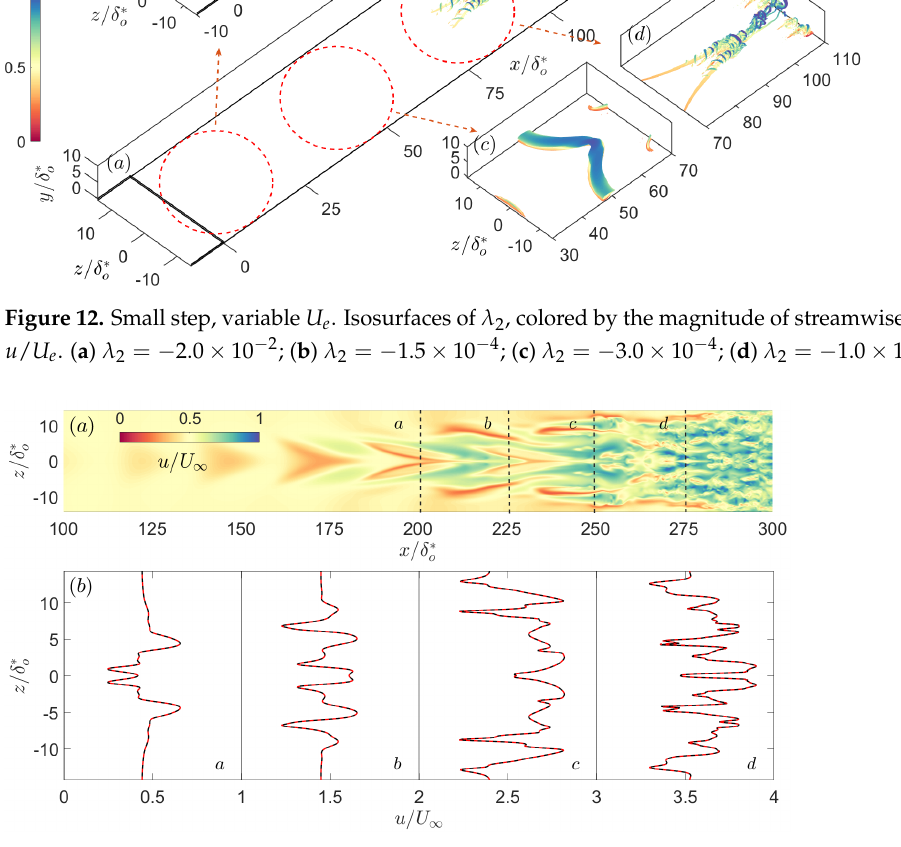
Figure 13. Flat plate. Instantaneous streamwise velocity in the y wall / δ ∗ o = 1.0 plane. ( a ) Velocity contours; ( b ) velocity profiles at the locations indicated by dashed lines in ( a ). t = t o ; t = t o + T